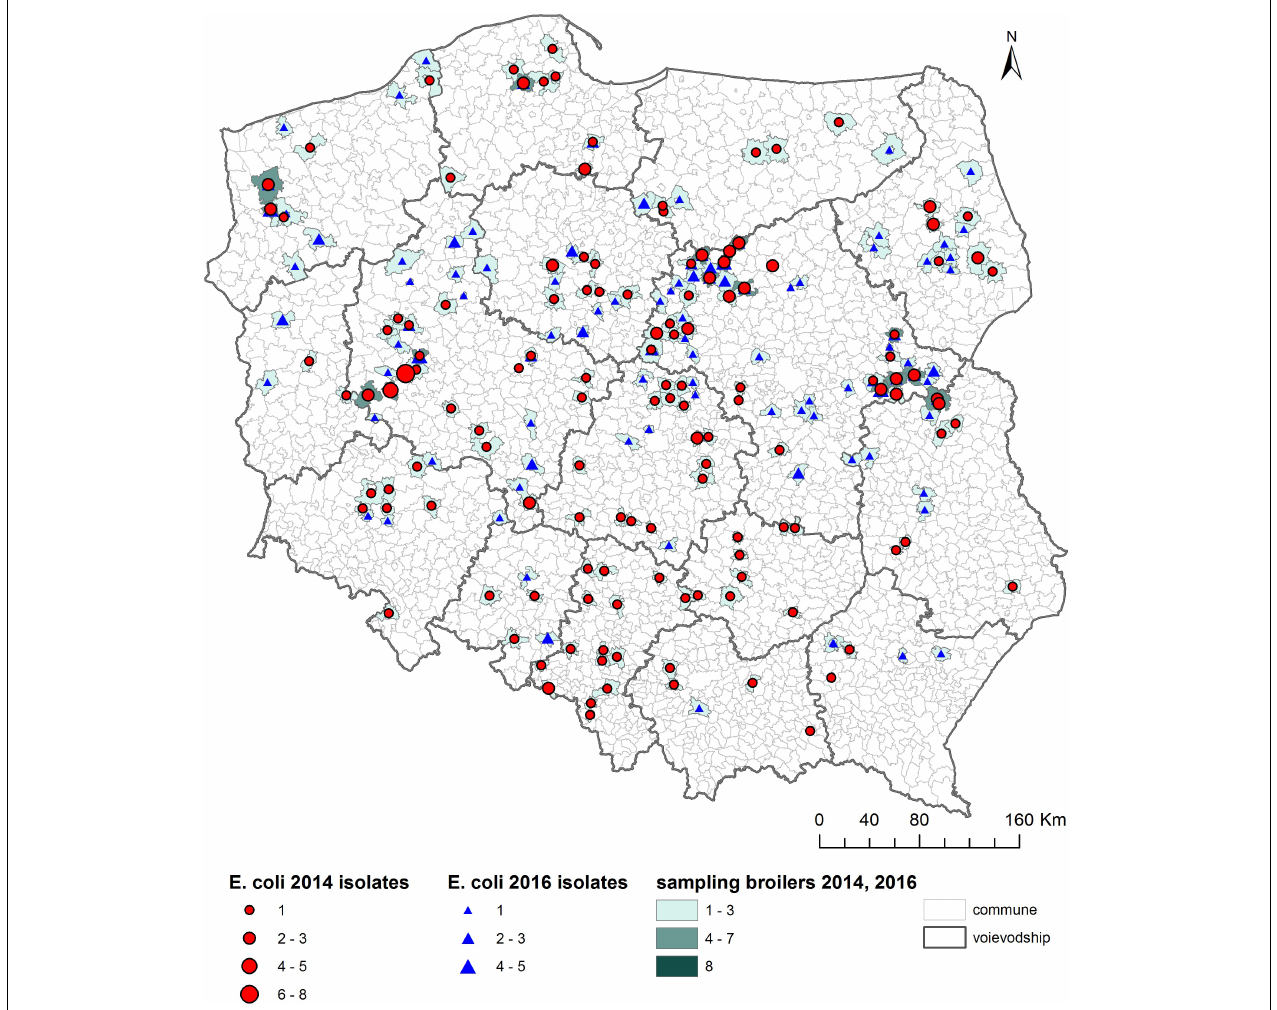
FIGURE 5 | Geographical distribution (commune level) of broiler sampling. Single broiler caeca was collected at slaughter and farm of origin was retrieved for verification of randomization of samples used for isolation of indicator E. coli in 2014 and